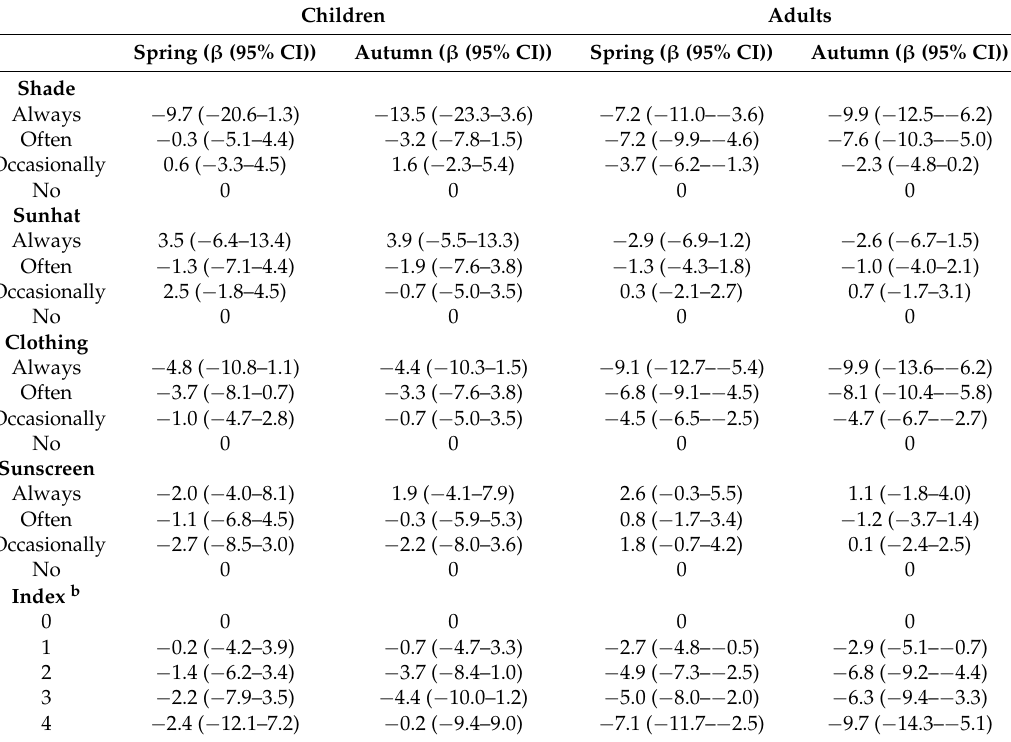
Table 2. Difference in vitamin D concentrations (nmol/L) according to adherence to the sun exposure guidelines and the combined index when the sun is shining between 12 and 3 p.m. in children ( n = 569) and adults ( n = 2625) in StatusD a .